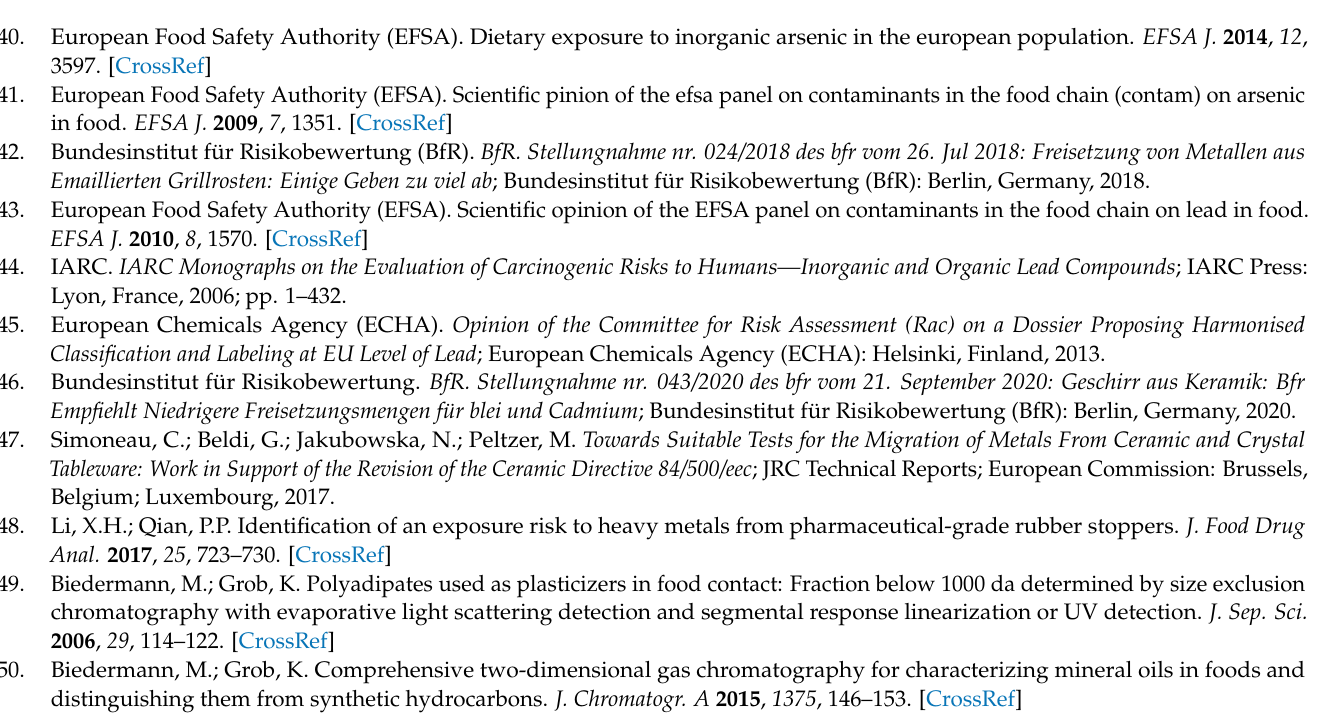
Tableware: Work in Support of the Revision of the Ceramic Directive 84/500/eec ; JRC Technical Reports; European Commission: